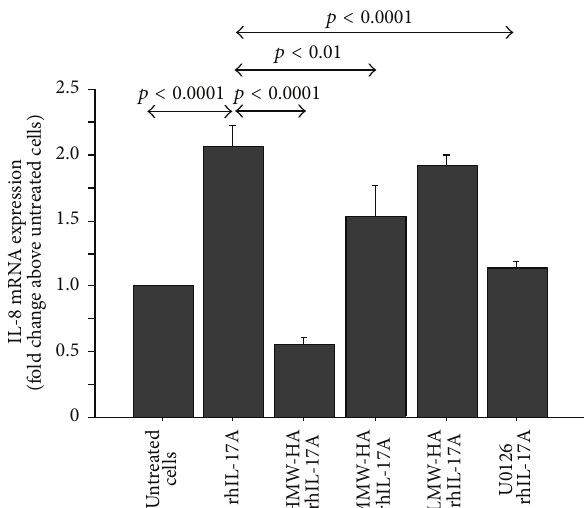
Figure 6: Effect of HMW-HA, MMW-HA, LMW-HA, and U0126 on IL-8 mRNA transcript. The cells were preincubated with HMW- HA (100 𝜇 g/mL), MMW-HA (100 𝜇 g/mL), LMW-HA (100 𝜇 g/mL), and U0126 (25 𝜇 M) for 1h and then stimulated with rhIL-17A (20 ng/mL) for 18 hrs to study IL-8 mRNA. mRNA levels were quan- tified byquantitative Real-TimePCR(seeMaterialsand Methodsfor details).Thebarsrepresentthemean ± SDof3separateexperiments. ANOVA with Fisher’s test correction was used for the analysis of the data. 𝑝 < 0.05 was statistically